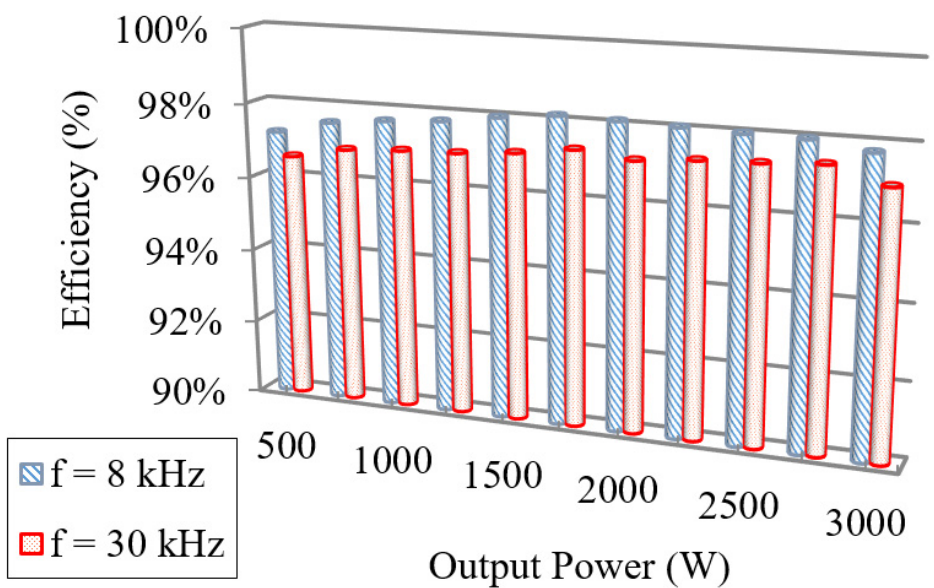
Figure 16. E ffi ciency analysis based on output power variations and frequency e ff ects.